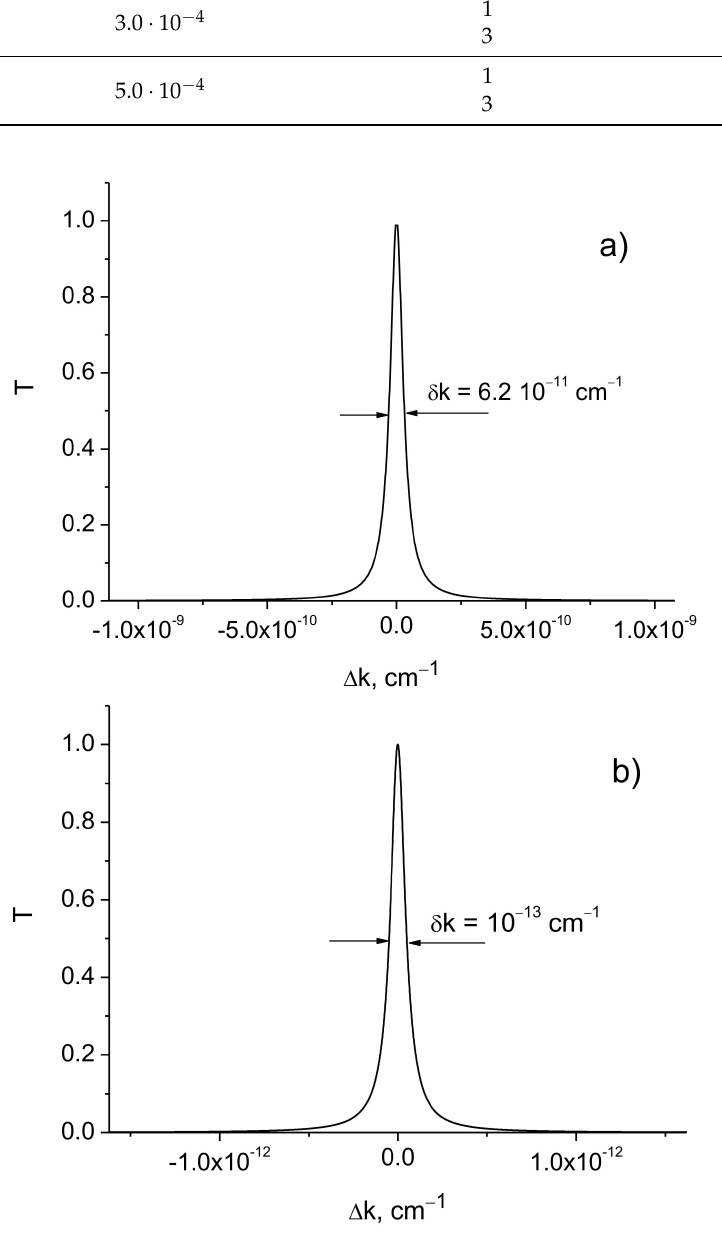
Figure 5. Transmission curves of the conventional F-P resonator: ( a ) 1 − R = 6 10 − 6 ; ( b ) 1 − R = 10 − 8 . d = 4 km, λ 0 = 630 nm. Table 5. The widths of transmission curves δ k for different values 1 − R and distances d. λ = 630 nm. 1 − R d ,